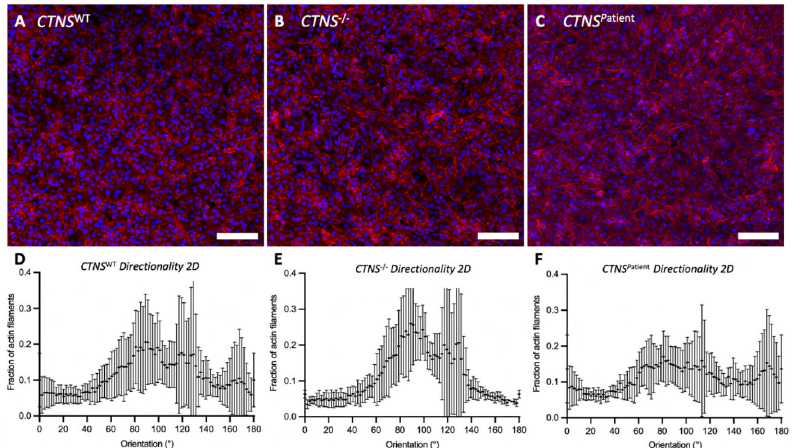
Figure 3. Cellular organization in 2D cell culture. Cells were stained using phalloidin to show the organization of actin filaments in ciPTEC CTNS WT ( A ), CTNS − / − ( B ), and CTNS Patient ( C ). Image directionality analysis revealed loss of organization in all the cell lines when cultured in 2D ( D – F ). In blue: DAPI (nuclei staining), in red: Phalloidin (binds to actin filaments). Directionality analysis was performed in two biological replicates Scale bar: 100 µ